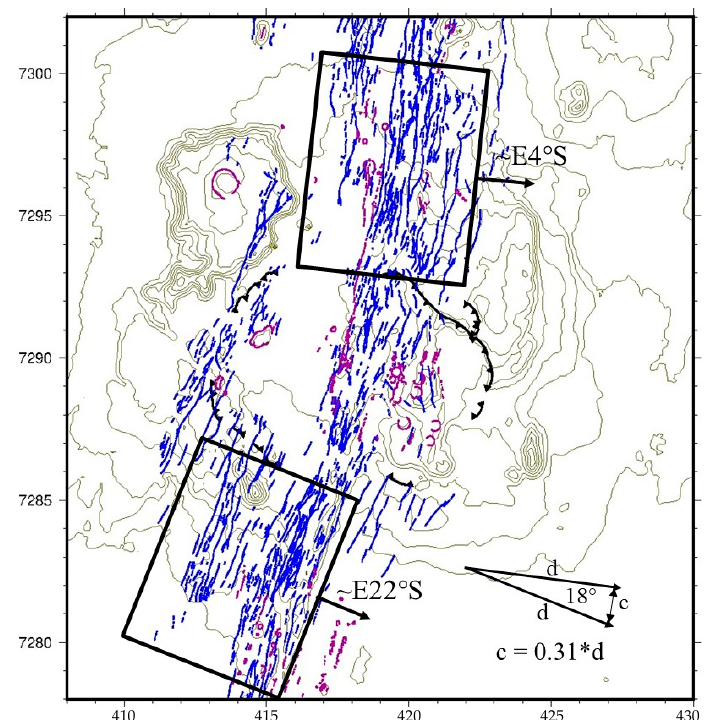
Figure 5. Different crustal spreading directions south and north of the Krafla caldera leading to an opening component in the eastern part. The inlet bottom right shows how spreading by, d, leads to opening component, c, in the east. Blue lines represent faults and fissures and purple lines eruptive fissures and craters. Coordinates are UTM WGS84 zone 28 in km.